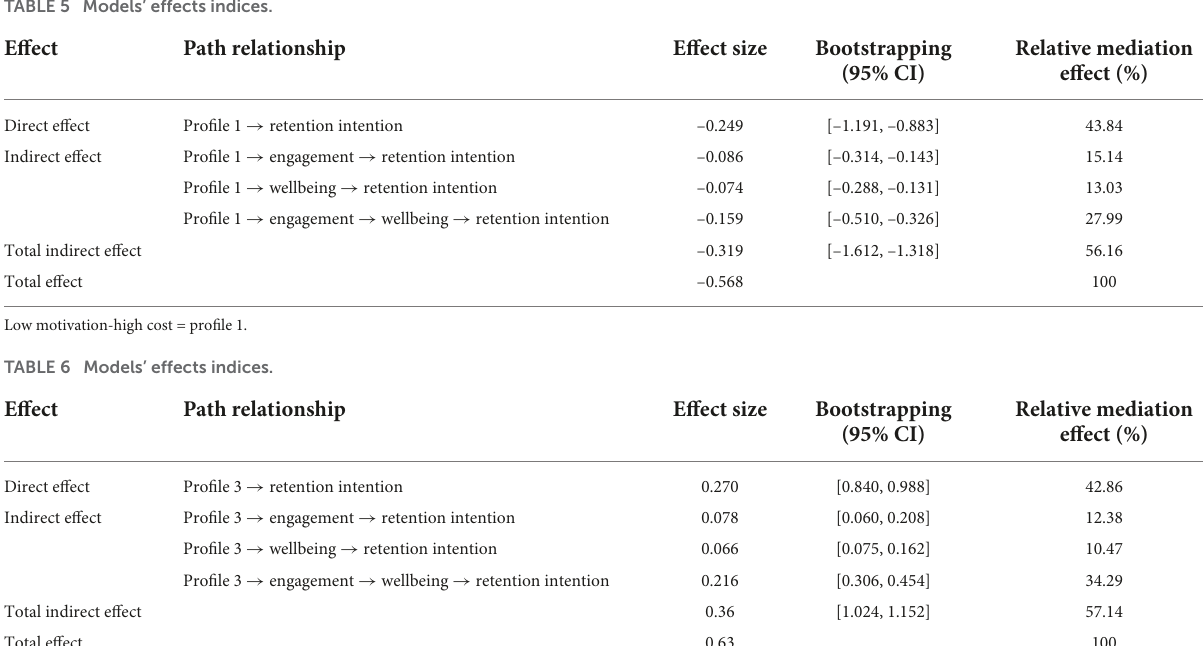
TABLE 5 Models’ effects indices.